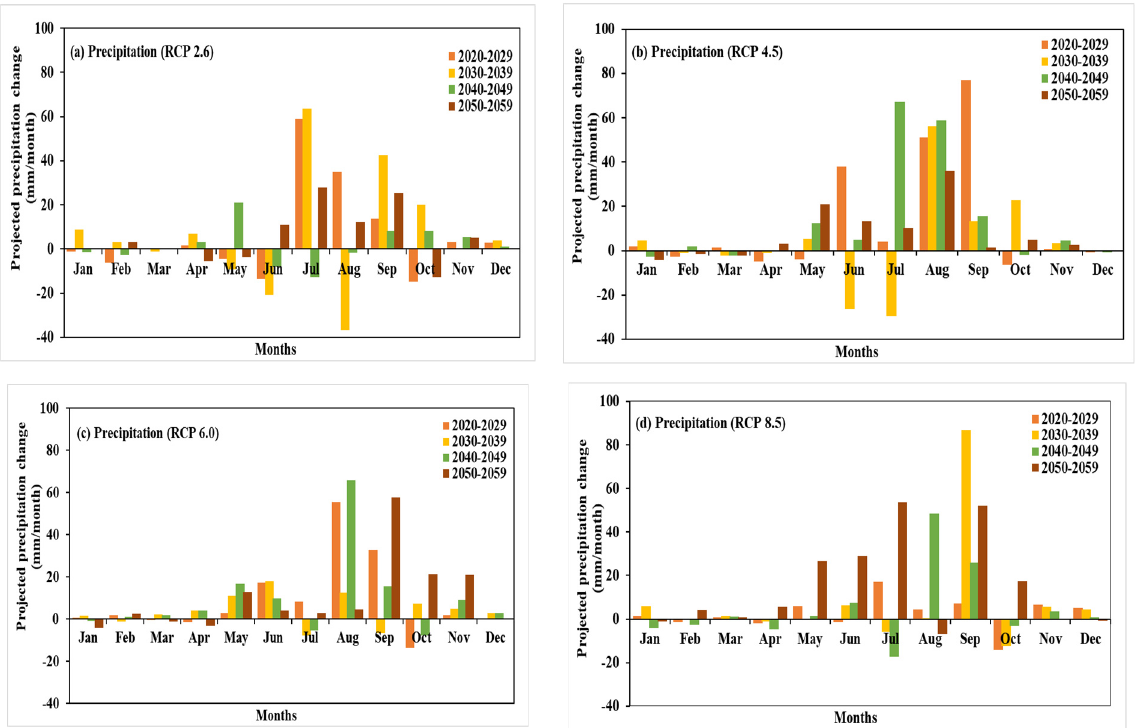
Figure 10. Projection of precipitation change for 10 years of the interval during 2020–2060 for ( a ) RCP 2.6, ( b ) RCP 4.5, ( c ) RCP 6.0, and ( d ) RCP 8.5.